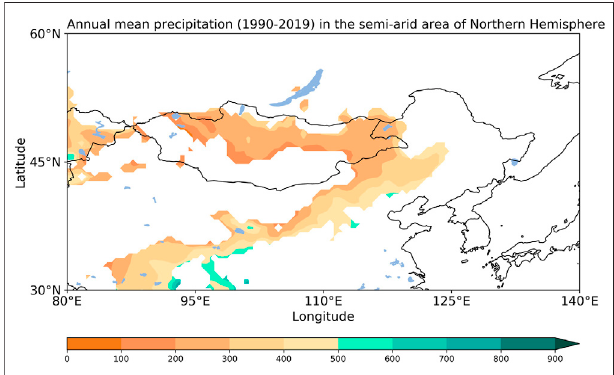
FIGURE 1 | Annual mean precipitation in the semi-arid area of East Asia during 1990 – 2019 (units: